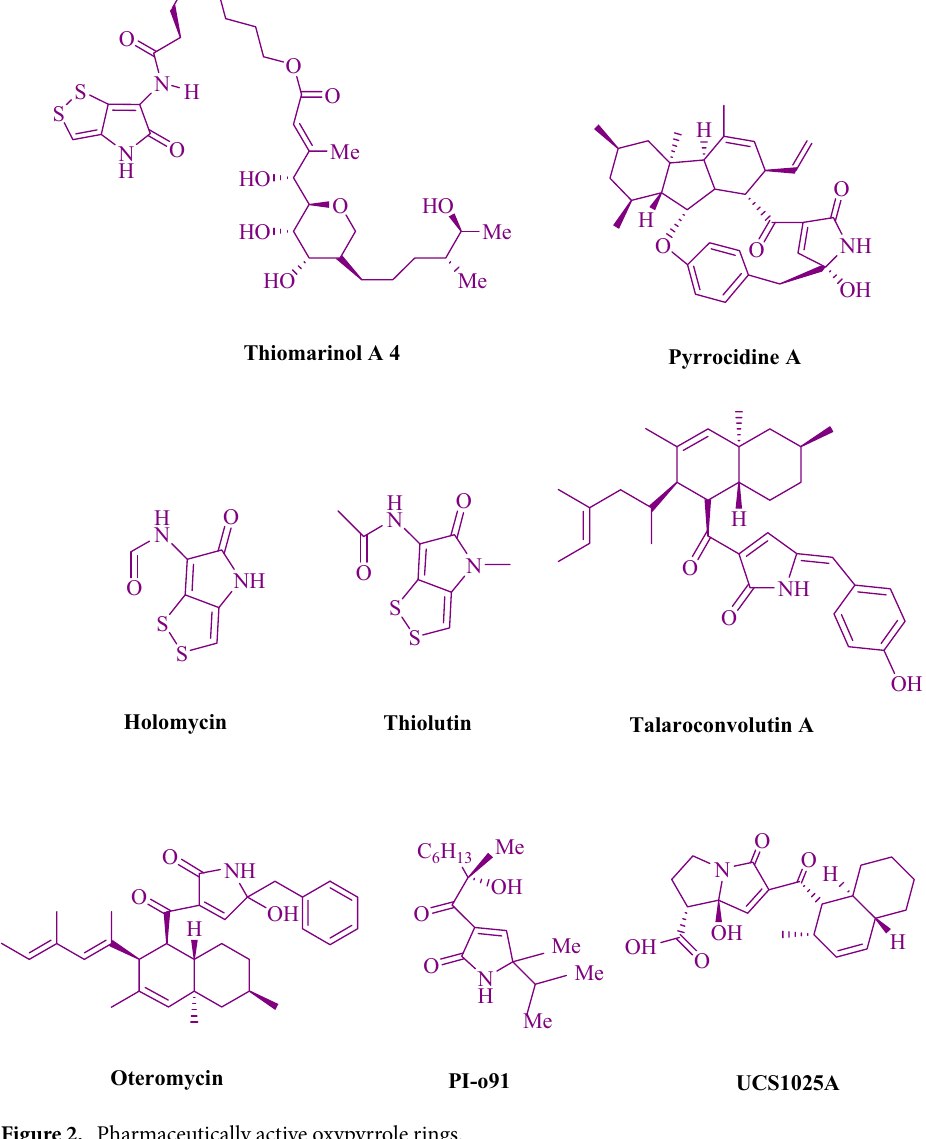
Figure 2. Pharmaceutically active oxypyrrole